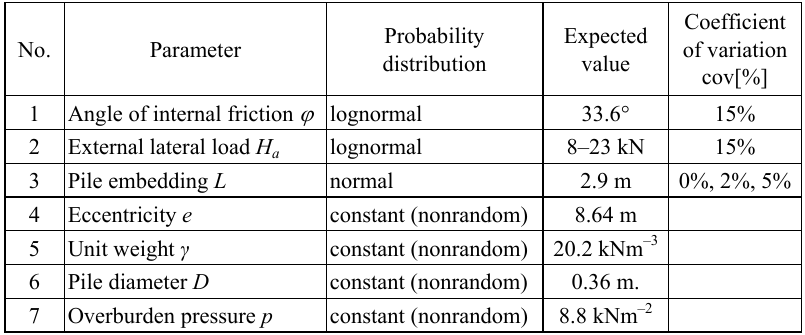
Table 6. Reliability indices obtained in analysis with three random variables ( φ , L , H a ) Total safety factor